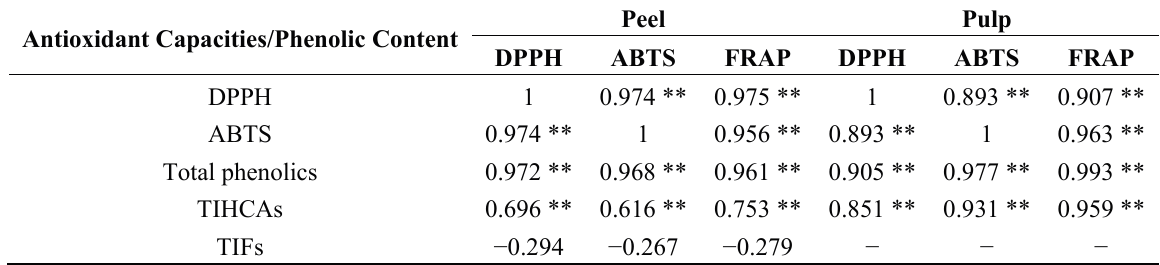
Table 6. Correlation coefficients between phenolic content and antioxidant capacities. Antioxidant Capacities/Phenolic